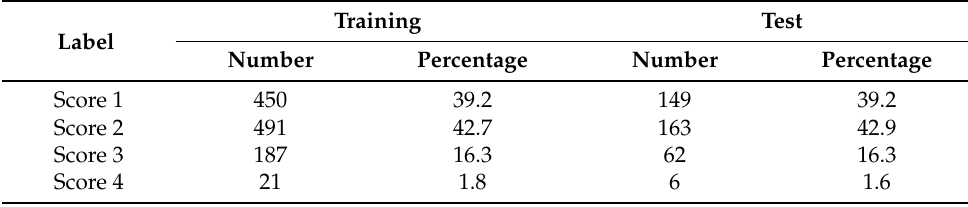
Table 1. Statistics of training and test